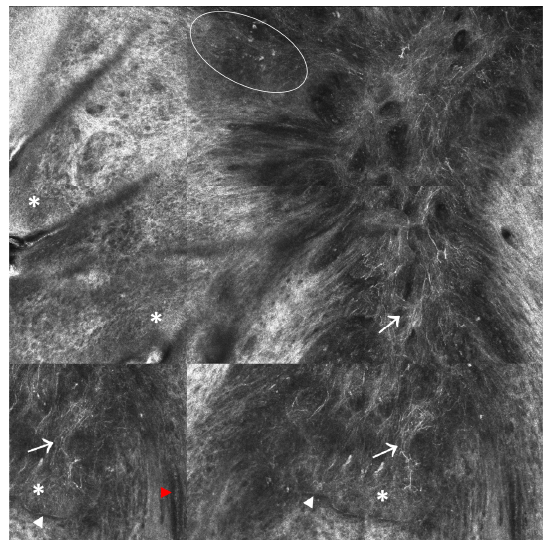
Figure 1. Basal cell carcinoma. RCM mosaic (1500 × 1500 µm 2 ) showing elongated cord-like structures and tumor islands (*) of different sizes delineated by dark clefts (white arrowhead). Large canalicular blood vessels (red arrowhead). Sparse plump-bright cells representing melanophages (white circle) and numerous bright cells with thin dendritic structures corresponding to melanocytes (white arrows) within the tumor